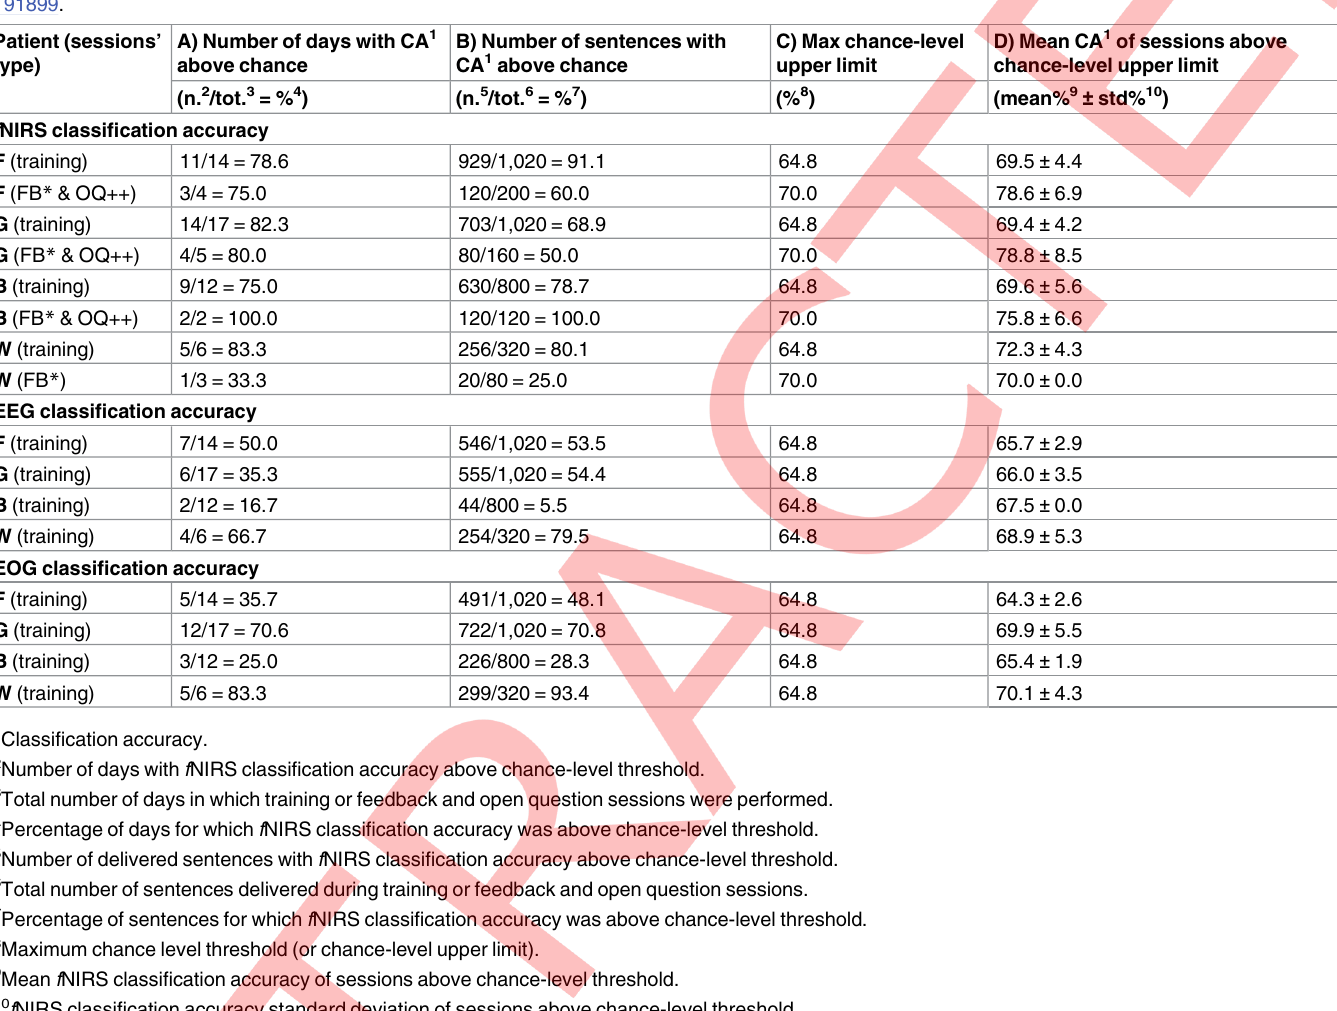
Table 2. Classification statistics. ( A) Numberof days with CA abovechancelevel;(B) numberof deliveredsentenceswith CA abovechancelevel; (C) max- imum chance-level upper limit, calculatedusing the metric describedin BCI effectiveness metric section; and (D) mean and standard deviationof CA above chance level, obtained using the f NIRS, EEG, and EOG signal data for patients F, G, B, and W. For the trainingsessions, the CA is reportedfor f NIRS, EEG, and EOG signals. For feedbackand open question sessions, CA is only reportedfor the f NIRS signal becausethe feedbackwas provided using only the f NIRS signalas a result of superiorCA of the f NIRS signal duringthe trainingsessionsas comparedto EEG and EOG signals. Table 2 data is locatedat https://doi.org/10.5281/zenodo.191884;https://doi.org/10.5281/zenodo.191887;https://doi.org/10.5281/zenodo.191891;https://doi.org/10.5281/zenodo.